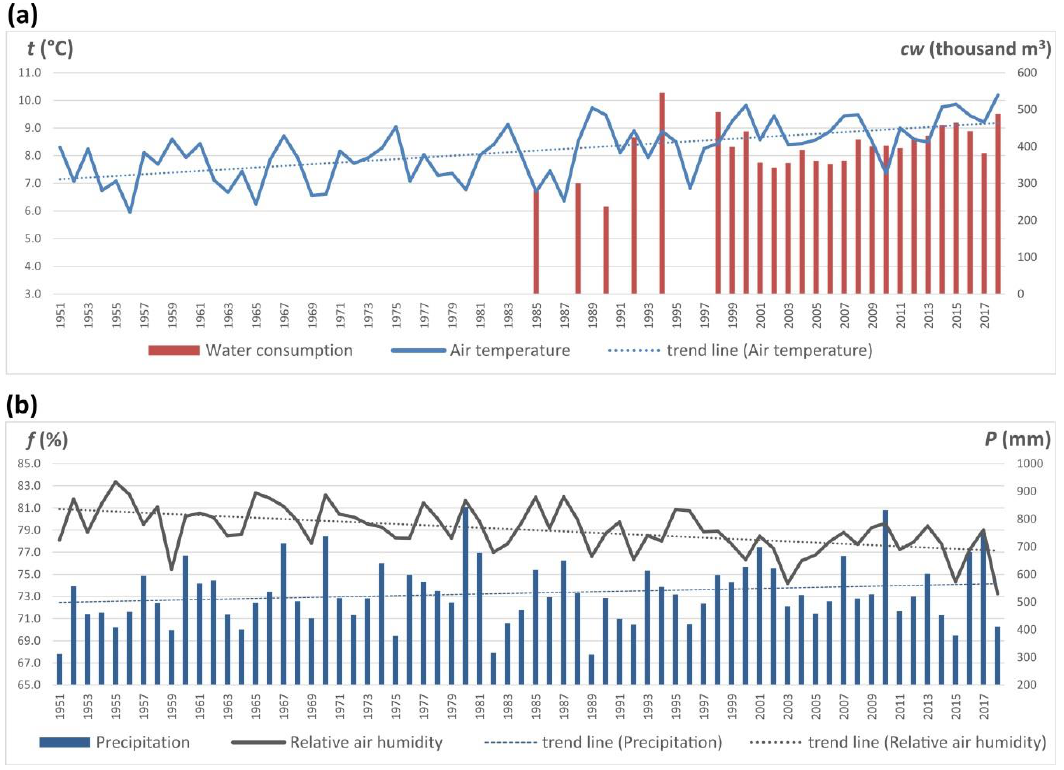
Figure 3. Air temperature ( t , °C), precipitation ( P , mm), and relative air humidity ( f , %) in the period